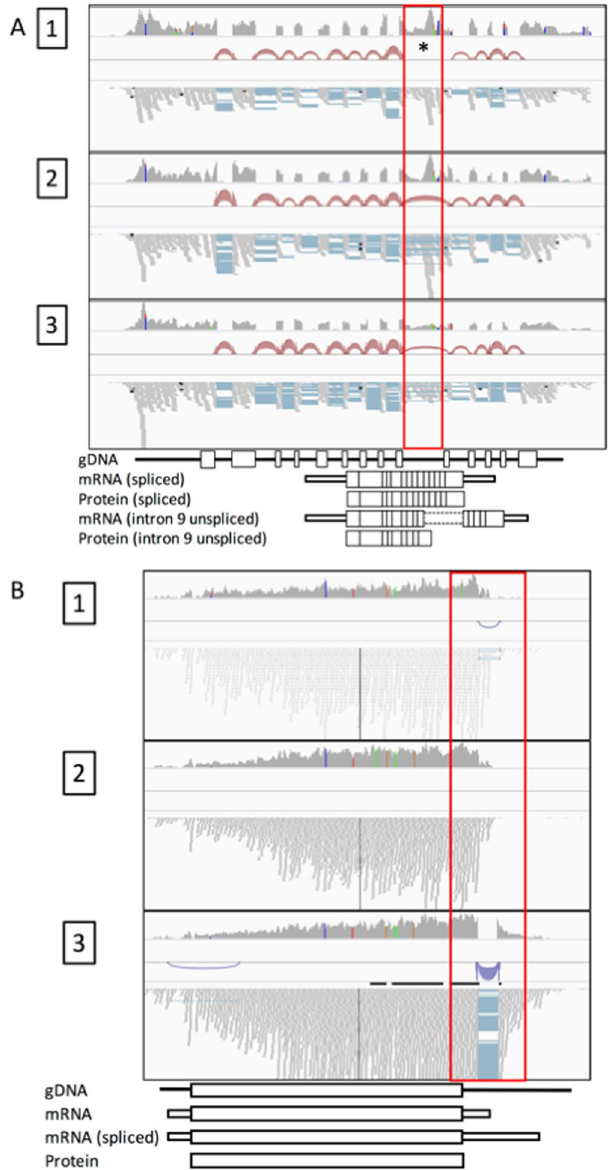
Figure 2. Examples of transcripts differing from the current P. vivax gene annotations. Data from each patient are displayed in successive rows (labeled 1–3). For each data set, the grey track shows the read coverage, the bridges display evidence of intron splicing and the blue and red bars the actual reads generated. ( A ) Read coverage across PvCRT. Note that intron 9 is retained in some of the transcripts from infections 2 and 3 and in all transcripts from infection 1 (red box). ( B ) Read coverage across PvMDR1. Note that in two infections, some PvMDR1 transcripts contains an unannotated intron in 3 ′ -UTR resulting in a longer transcript (red